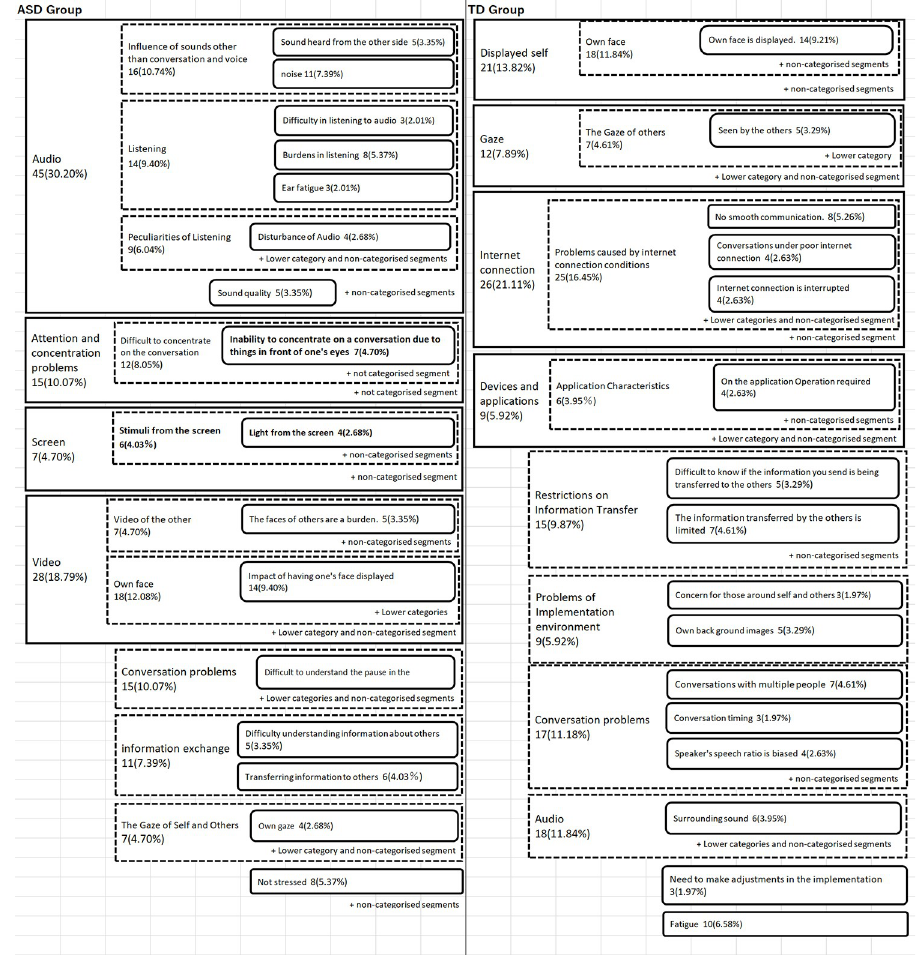
Fig 2. Results of KJ method analysis on the stress of video calling. Bolded category names indicate categories considered to have been shown to be characteristic of the ASD Group based on a comparison of the two groups. The numbers indicate the number of segments that mentioned the content belonging to the category, and the numbers in parentheses indicate the percentage of the number of all segments in each group.